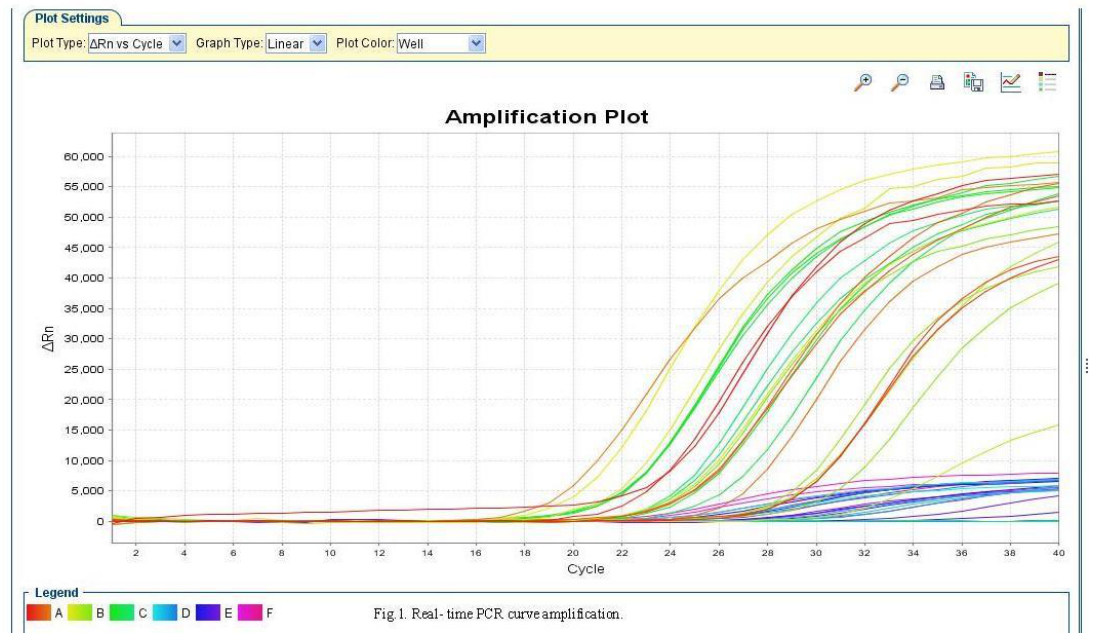
Fig. 1. Real-Time PCR curve amplification.